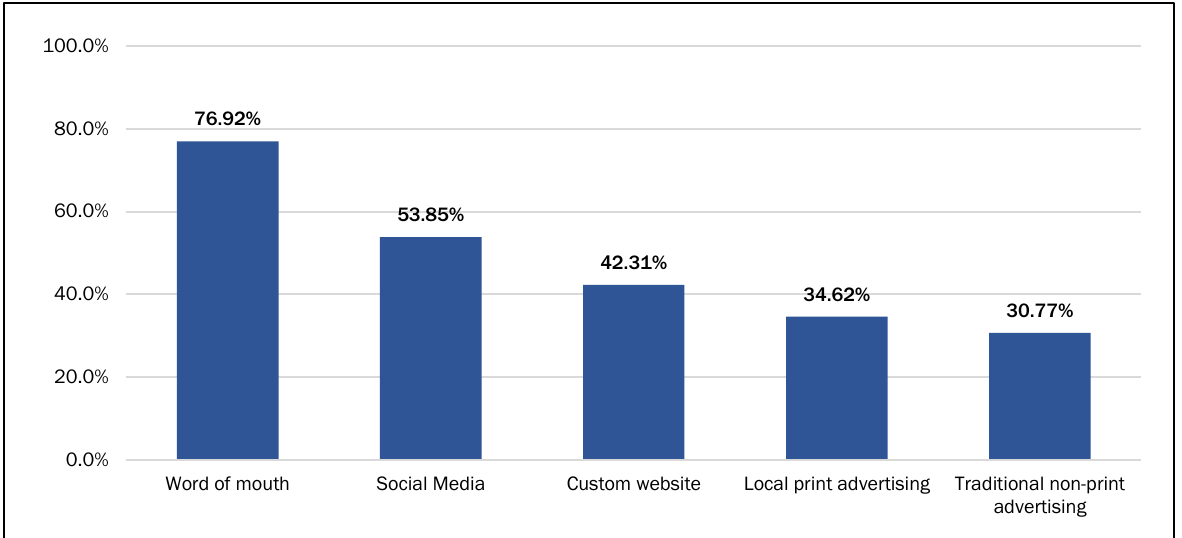
Figure 5. Marketing Strategies Used by Small- and Very-Small – Scale Meat Processors ( N